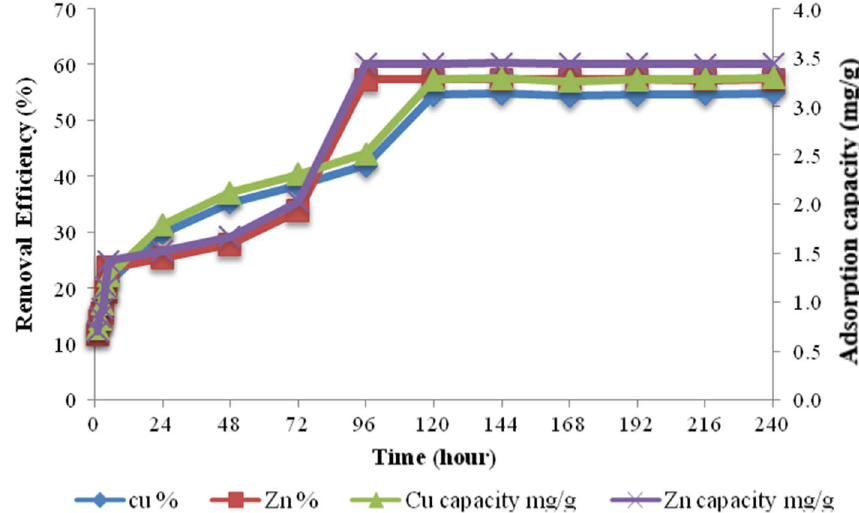
Fig. 2 The effect of contact time on the biosorption of Cu and Zn by E. coli biofilm on zeolite (metal concentra- tion: 36.36 mg/L, incubation temperature: 28 °C, shaker rate: 150